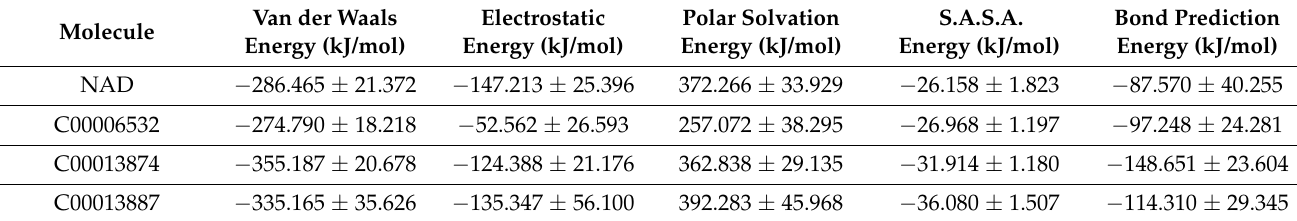
Table 1. MM-PBSA energy summary from nature ligand (NAD) and the three best quercetin analogs. Van der Waals Electrostatic Polar Solvation S.A.S.A. Bond Prediction Molecule Energy (kJ/mol) Energy (kJ/mol) Energy (kJ/mol) Energy (kJ/mol) Energy (kJ/mol) NAD − 286.465 ±